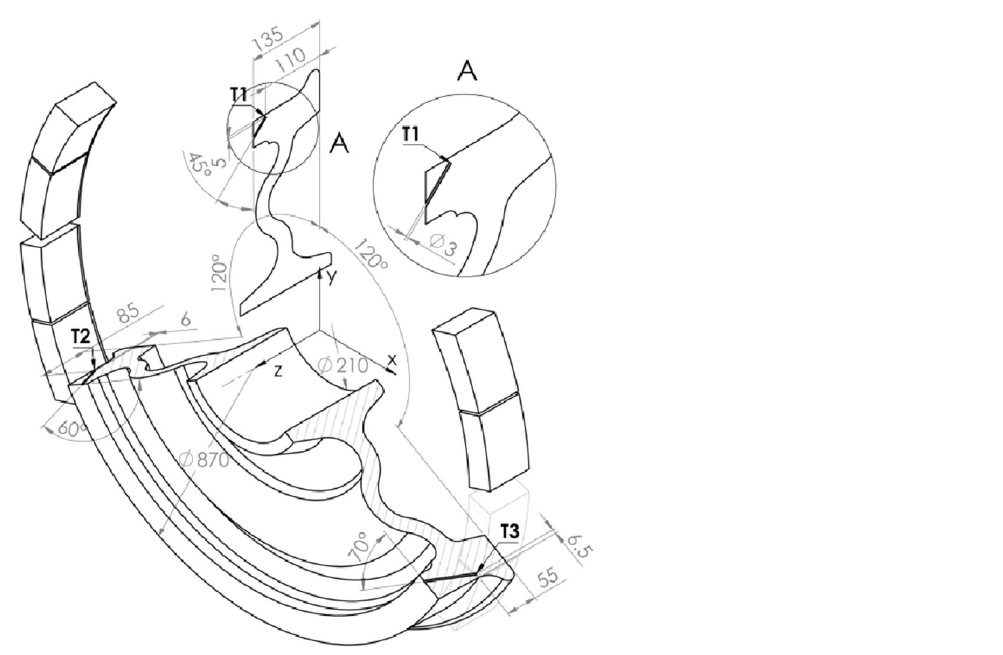
Figure 4. Scheme of the arrangement of thermocouples T1, T2, T3 in a railway wheel with selected